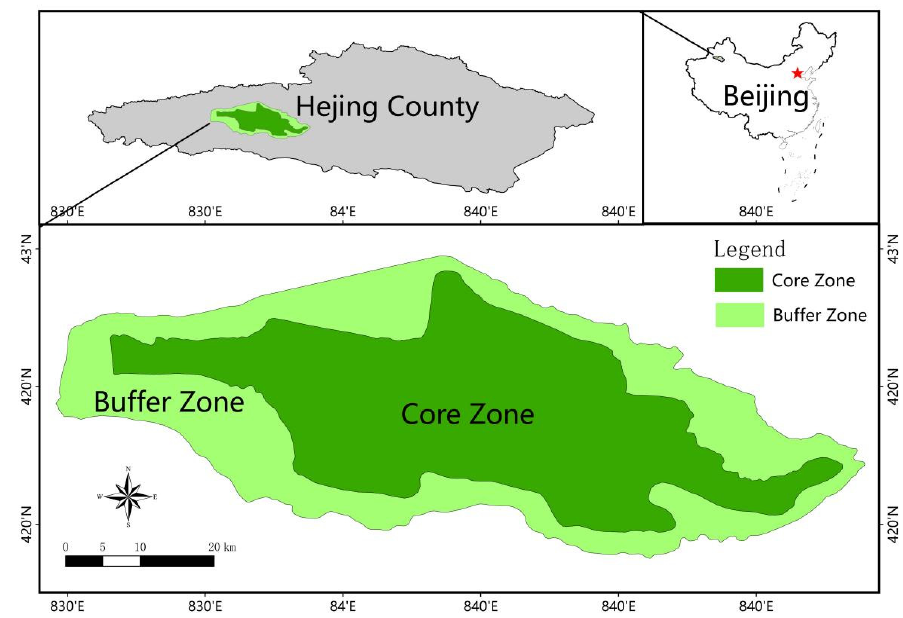
Figure 2. Bayanbulak Heritage Site geographical location (Source: